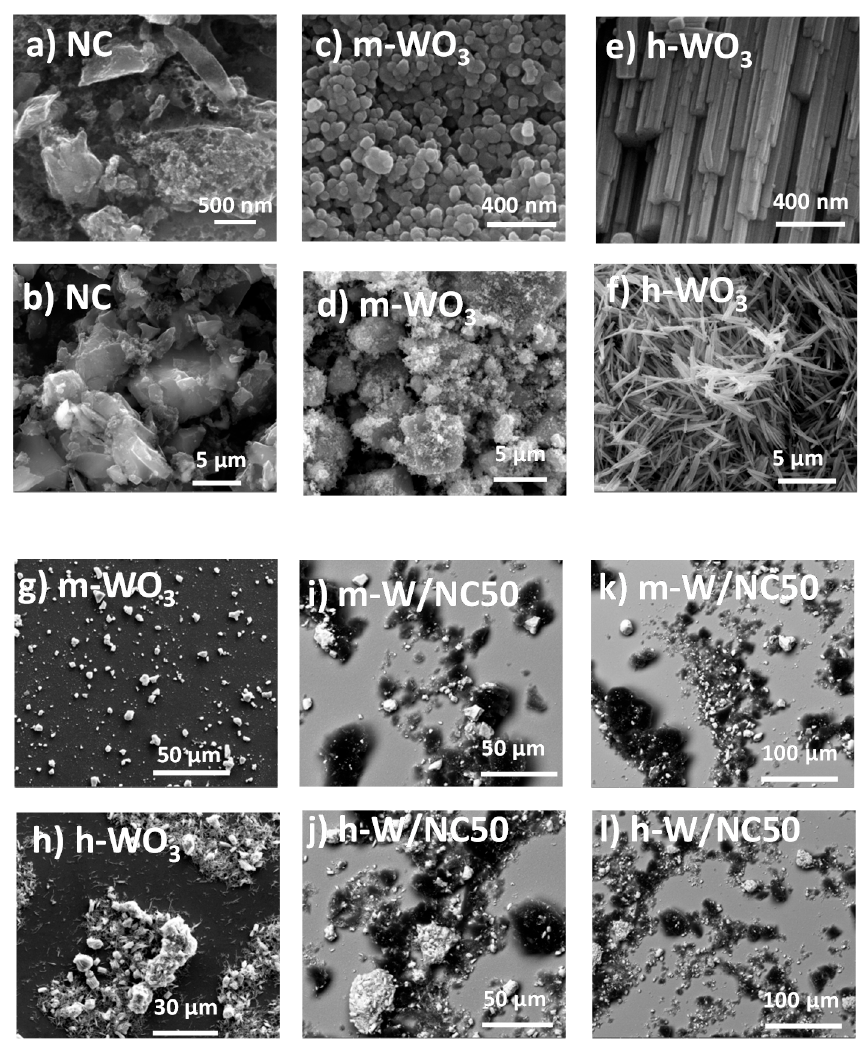
Figure 2. SEM images of ( a , b ) the nanoporous carbon additive, ( c , d ) monoclinic and ( e , f ) hexagonal WO 3 , and selected electrodes on the FTO support for ( g , h ) the semiconductors and ( i – l ) the mixture with 50 wt % of carbon additive.